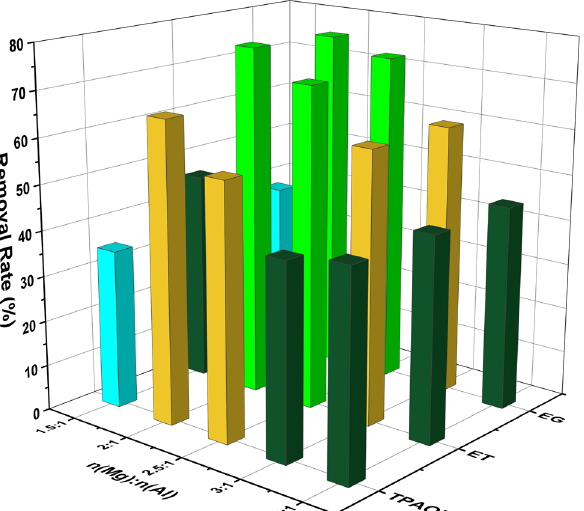
Figure 1: The removal rate of SO 42− with di ff erent LDH.